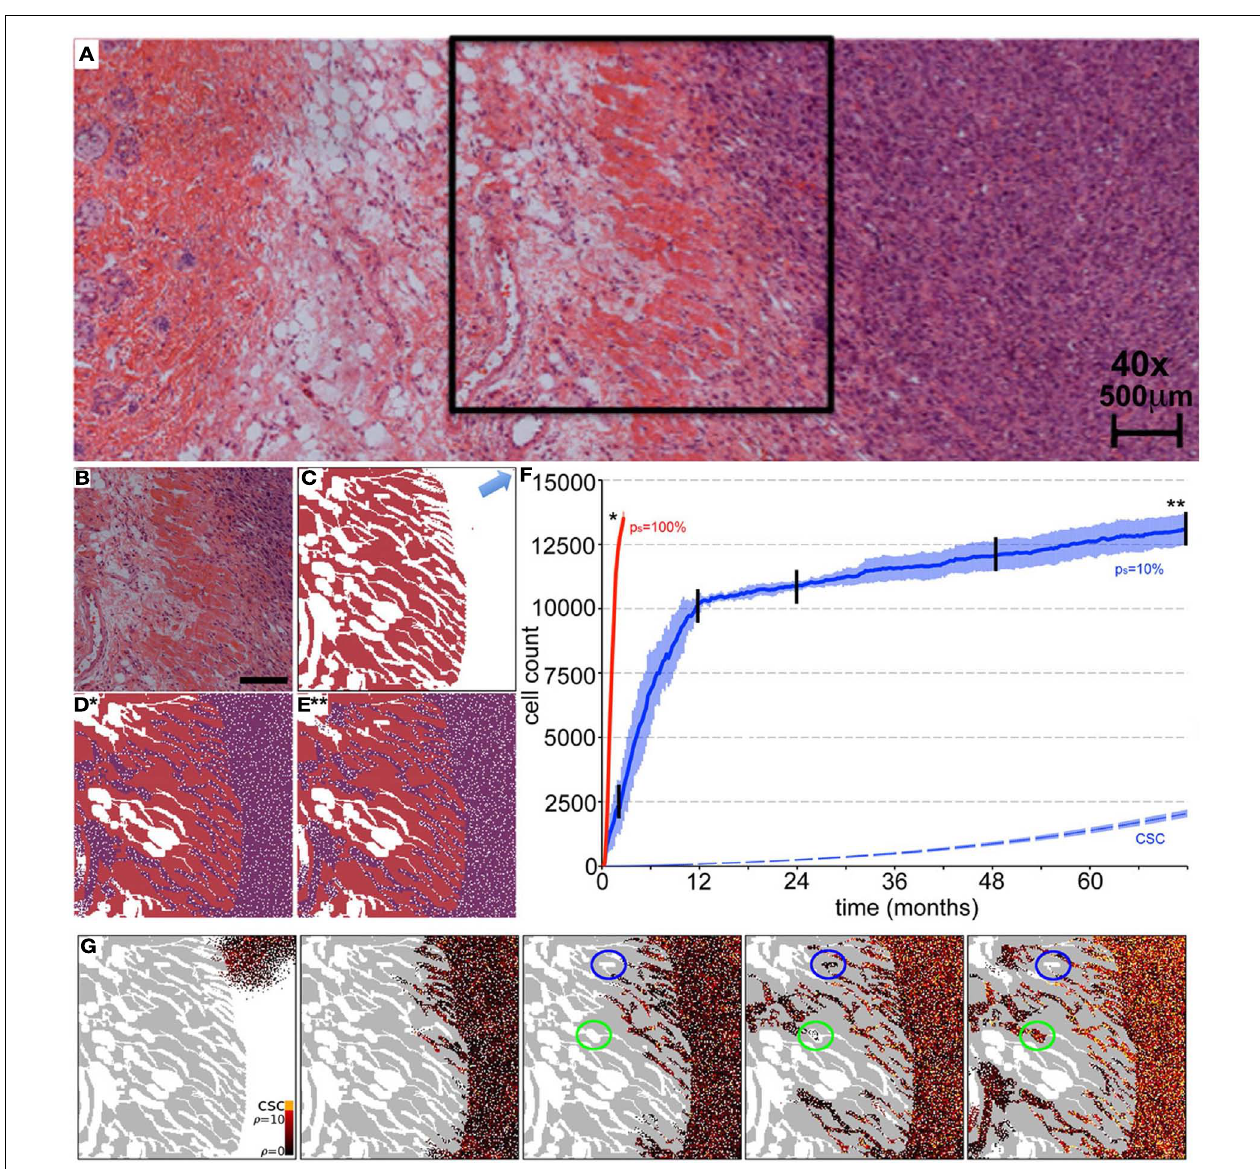
the heterogeneous tumor ( p s = 10%) takes more than 72months. In the latter case, the area outside the muscle is completely occupied after 12months, harboring 60 cancer stem cells (dashed blue plot). By time 72months, the number of cancer stem cells outside the muscle has increased to 2050. Shown are the averages and standard deviations of 10 independent simulations (G) Representative simulation snapshots of different time points of tumor growth and invasion in a tumor with p s = 10%.The time points are marked in (F) with black vertical lines.The space adjacent to the muscle is quickly occupied, whereas the invasion of the muscle architecture takes a long time. Stem cells must invade to seed new cells in the less dense tissue within and beyond the muscles, but their invasion is inhibited by their non-stem offspring with limited proliferation capacity. Non-stem microtumors cannot be sustained and disappear over time (blue circles). Microtumors seeded by a stem cell manifest and become very stemmy (green circles).The stem cell pool in the tumor adjacent to the muscle increases steadily over time as non-stem daughter cells die off over time ( α =